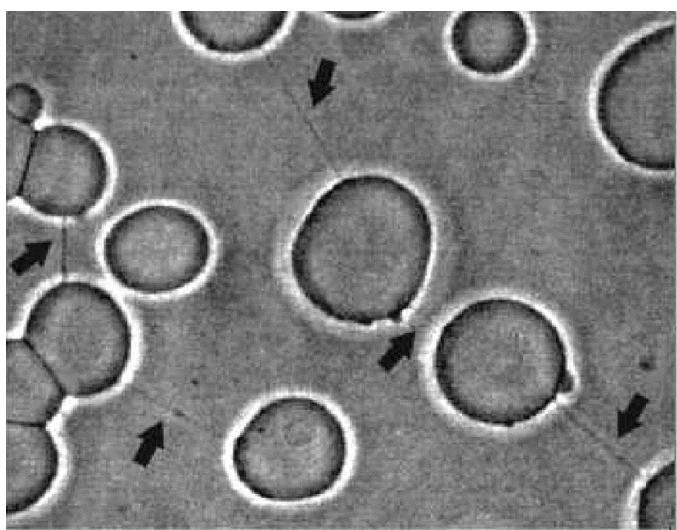
Figure 3. POPC–cholesterol–cardiolipin GUVs connected by thin nanotubular connections (indicated by black arrows) (adapted from Reference [50]). The GUVs were prepared by the modified method of electro-formation